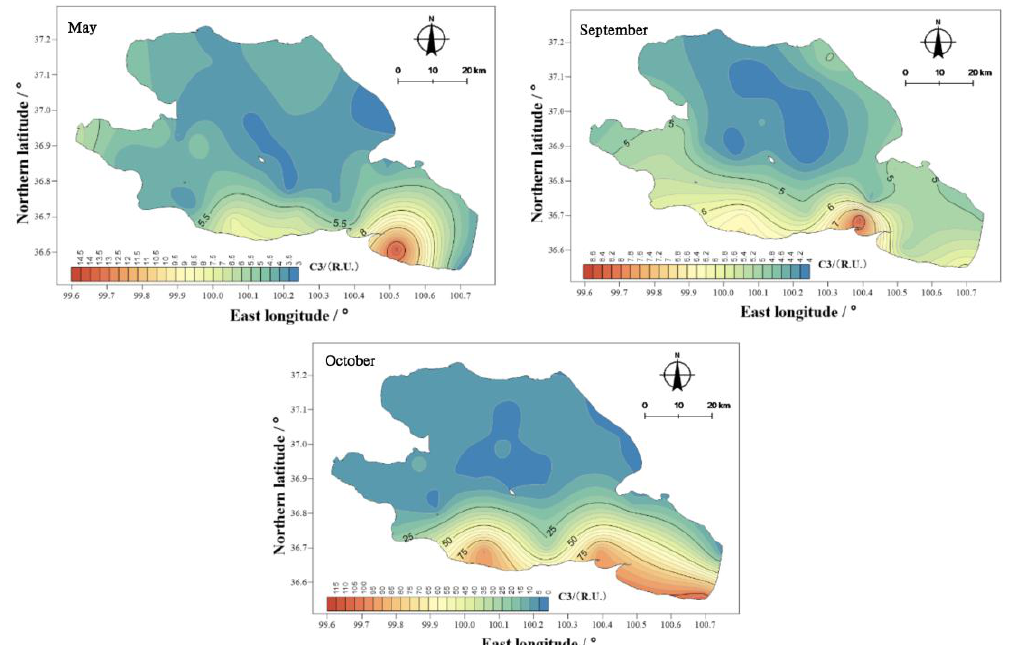
Figure 17. Spatial distribution characteristics of the fluorescence intensity of component C3 in Qinghai Lake in different seasons.